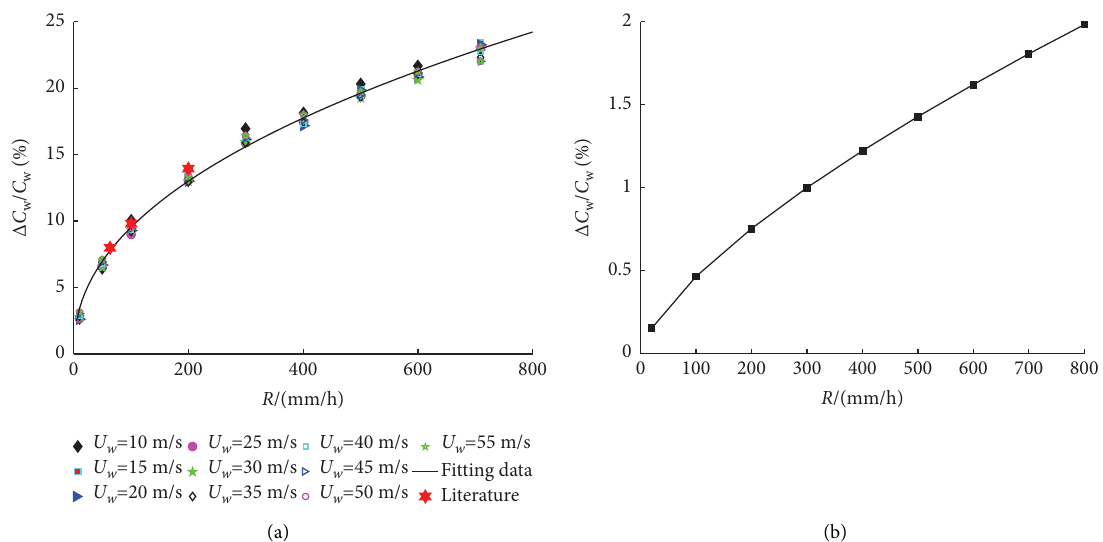
Figure 30: Proportion diagram of rain load. (a) Transient pulse load superposition. (b) Momentum average rain